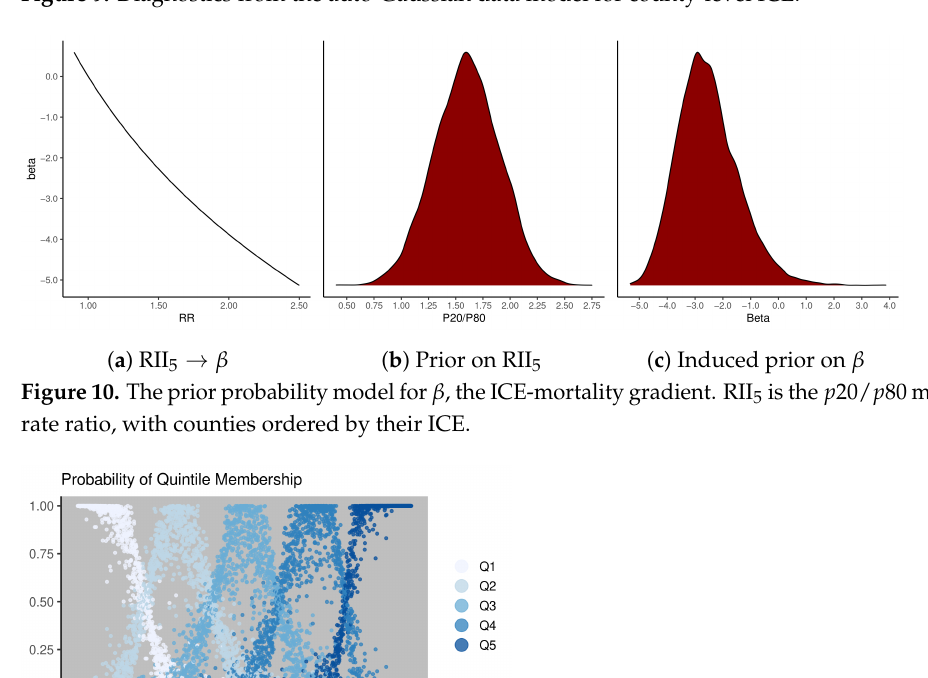
Figure 9. Diagnostics from the auto-Gaussian data model for county-level ICE.